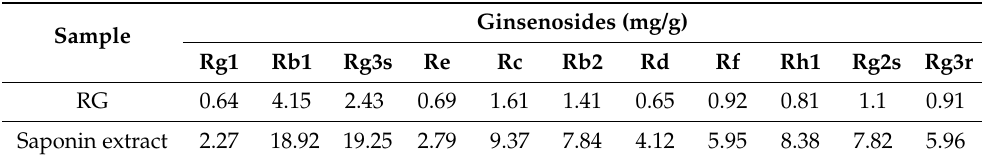
Table 3. Contents of the eleven ginsenosides in red ginseng (RG) and saponin extract.